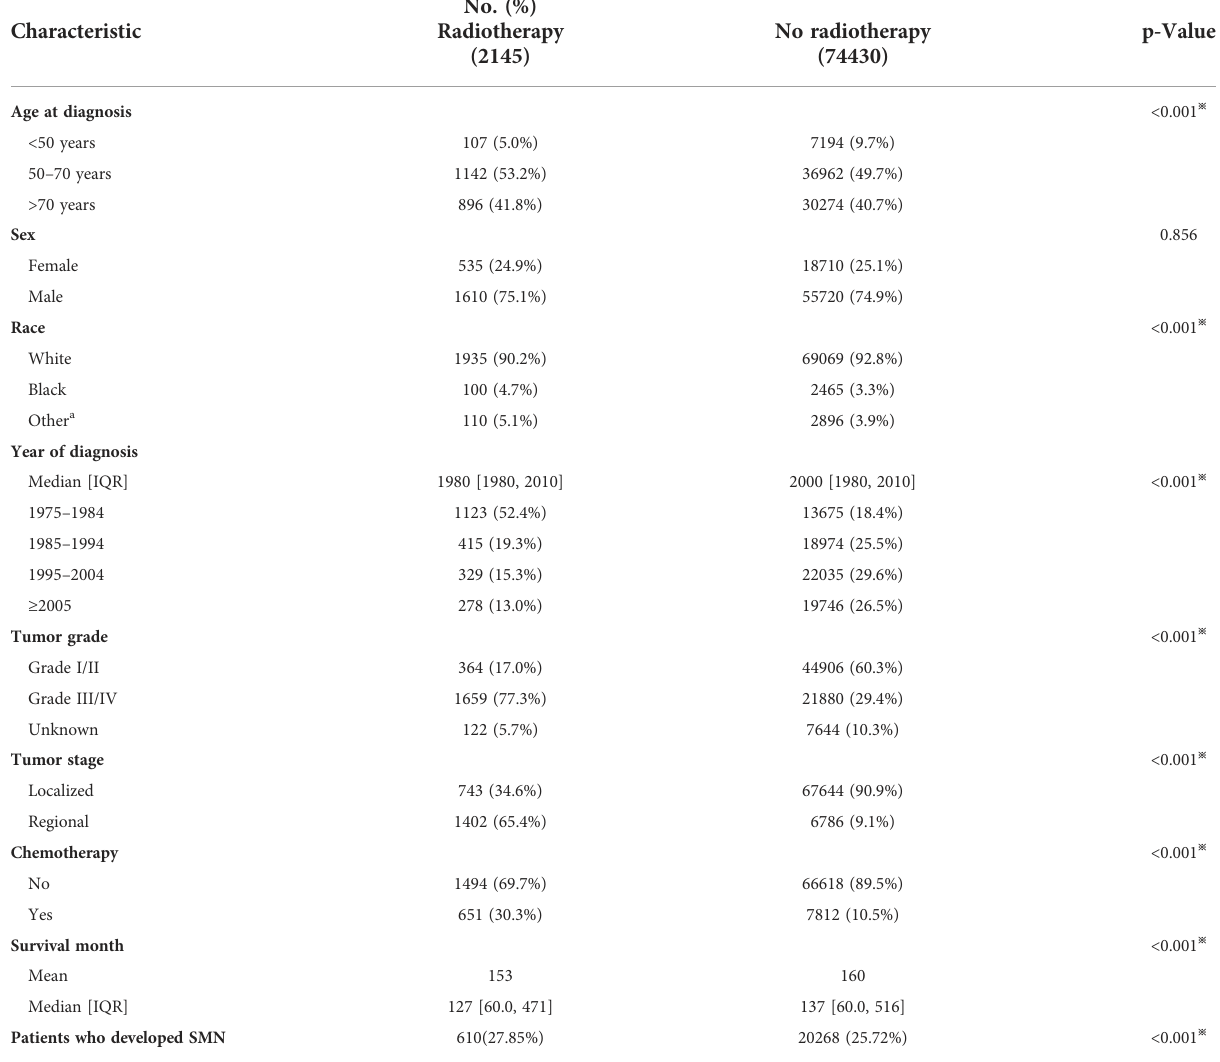
TABLE 1 Comparisons of baseline characteristics of patients with bladder cancer by treatment